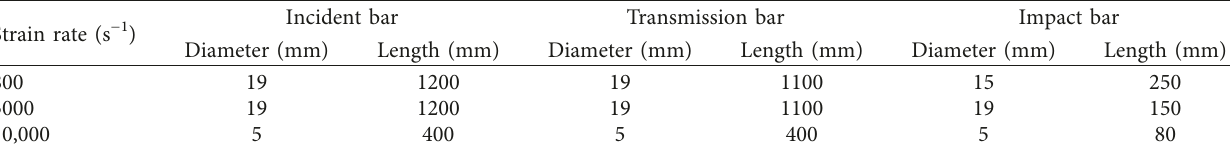
Table 2: Specifications for split Hopkinson bar system